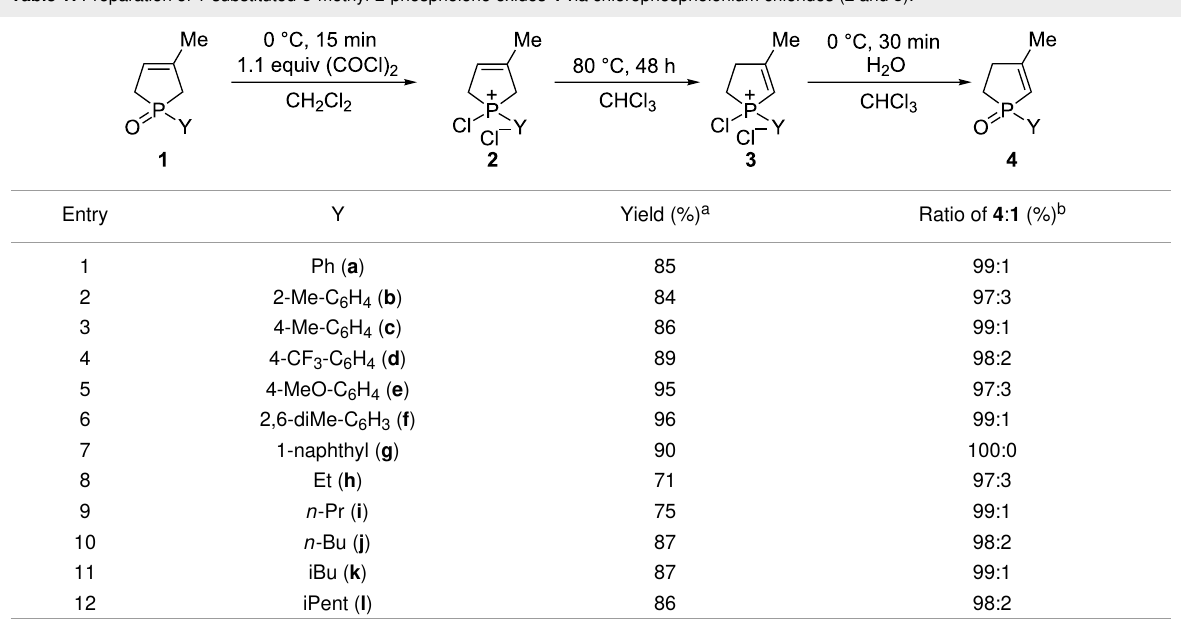
Table 1: Preparation of 1-substituted-3-methyl-2-phospholene oxides 4 via chlorophospholenium chlorides ( 2 and 3